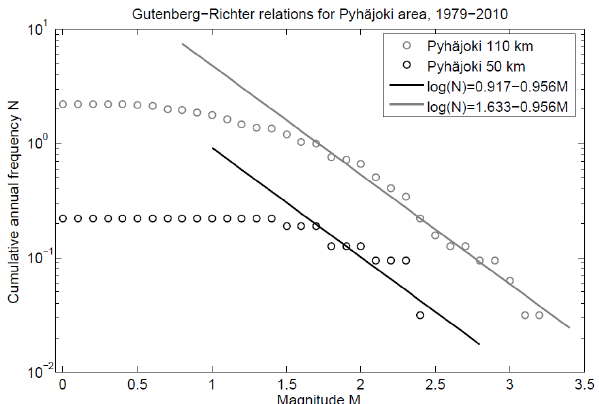
Fig. 5. Magnitude-frequency curves for earthquakes recorded Figure 5. Magnitude-frequency curves for earthquakes recorded within 110 km and 50 km 2 within 110 and 50km radius of the study site during 1979–2010. radius of the study site during 1979 - 2010. The slope, i.e., the b -value that defines the ratio of 3 The slope, i.e. the b-value that defines the ratio of small to large small to large earthquakes, determined for the 110 km data is also applied to the 50 km data. 4 earthquakes, determined for the 110km data is also applied to the 50km data.